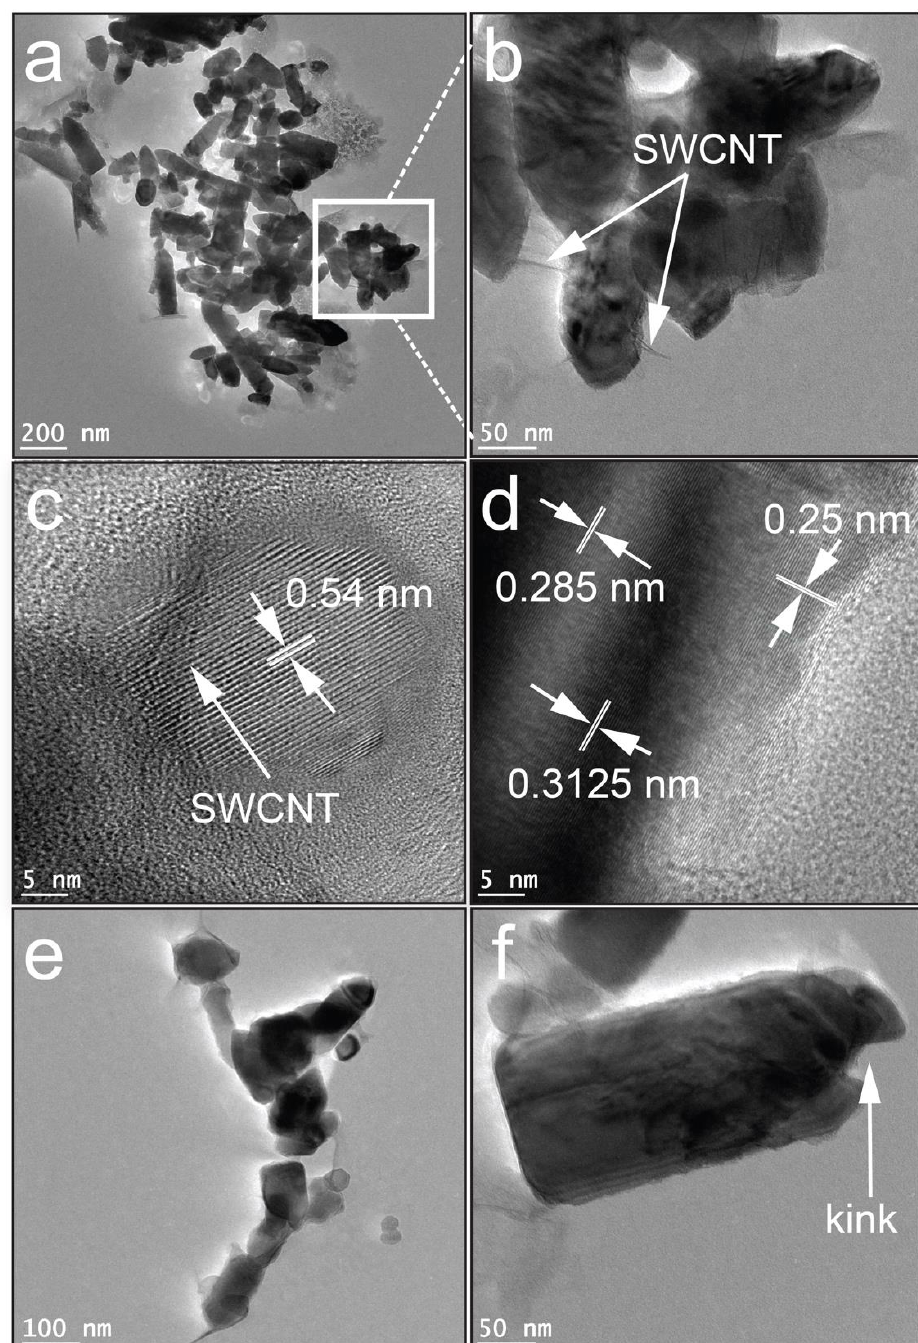
Figure 3 . HR-TEM images of the ZSC nanocomposites: ( a ) ZSC2, ( b ) enlarged micrograph of Figure 3a, ( c – d ) lattice fringes of the ZSC3 nanocomposite, ( e ) magnified view of the ZSC3 nanoparticles, and ( f ) enlarged micrograph of a single ZSC3 nanoparticle with a defect.